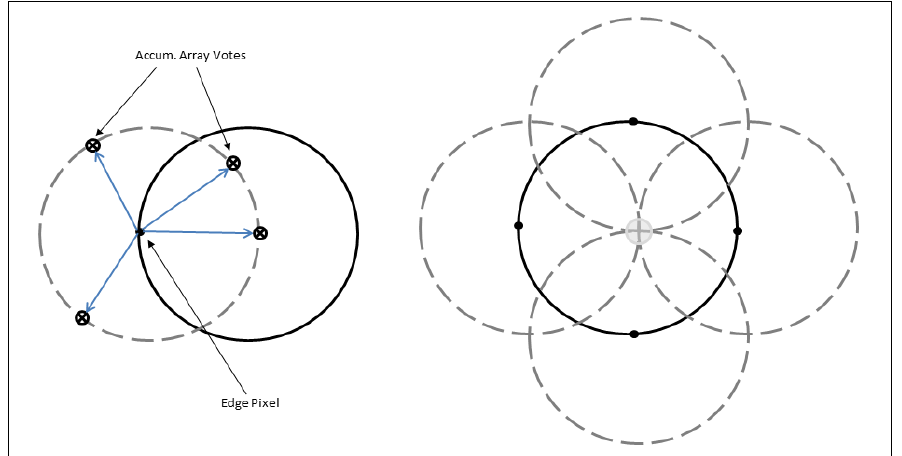
Figure 4. Circular Hough transform voting pattern.